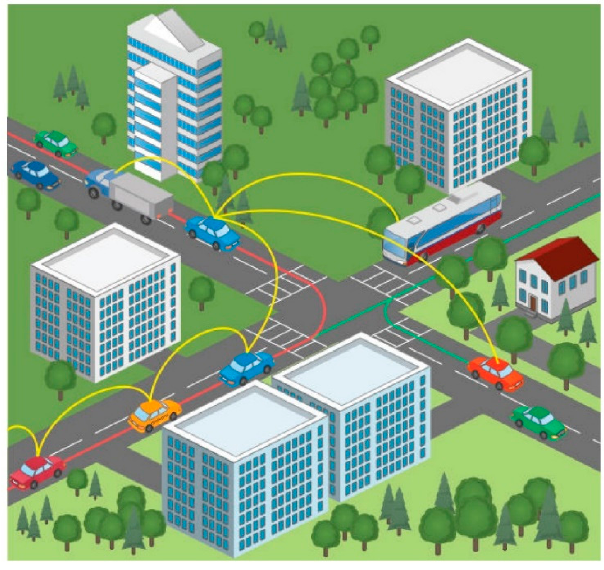
Figure 1. Illustration of how vehicles can communicate with each other in a hop-by-hop manner within a VANET [1].